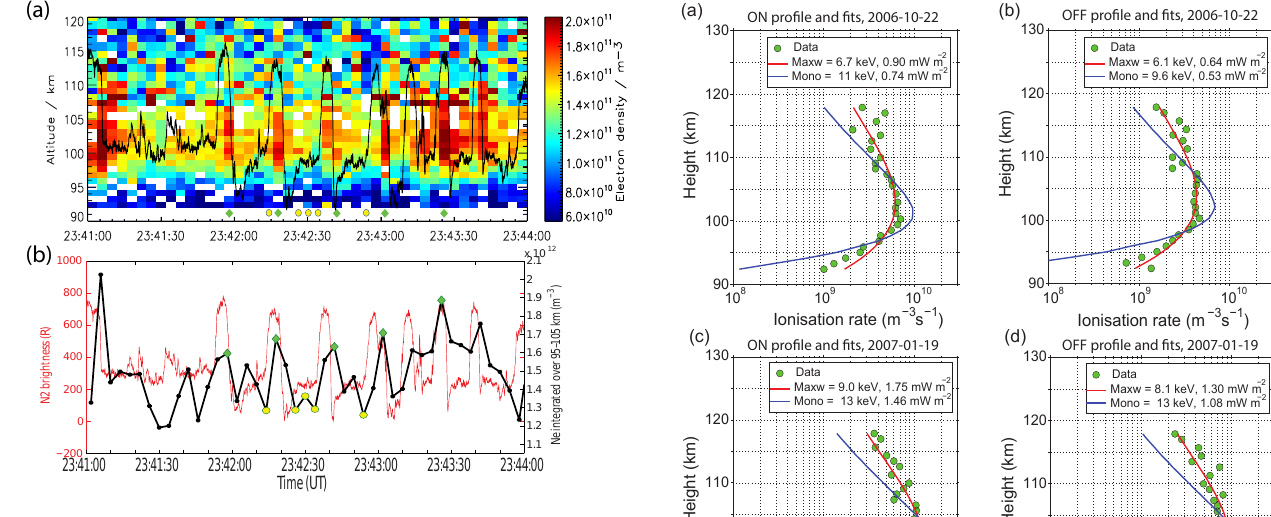
Figure 2. (a) Electron density as a function of time and altitude, as measured by EISCAT on 22 October 2006. The pulsations are seen as regular electron density enhancements. I N is plotted on top 2 in black. (b) Temporal evolution of electron density integrated over 95–105km altitude (black) and ASK I N (red). The green diamonds 2 mark the five data dumps that are averaged to investigate the elec- Figure 3. (a) Ionisation rate profile from EISCAT electron density tron profile during ON, and the yellow circles mark the selected data data averaged over five measurements during ON periods is shown points to create an average density profile during OFF. as green dots from the 2006 event. The line plots are the best fits to the data, as derived with a Maxwellian (red plot) and monoenergetic (blue plot) distribution of the electron spectrum. (b) Same as in (a) , but for five averaged electron density profiles during OFF periods of the pulsations. (c) Same as in (a) , but for the 2007 event. (d) Same as in (b) , but for the 2007